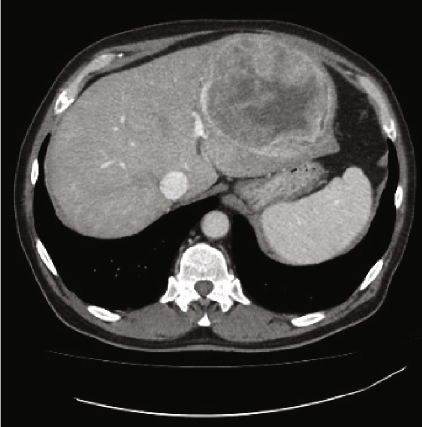
Figure 2: The surgical specimen showed a well-circumscribe solid mass ( 14 : 6 × 13 : 0 × 10 : 0 cm ) with central